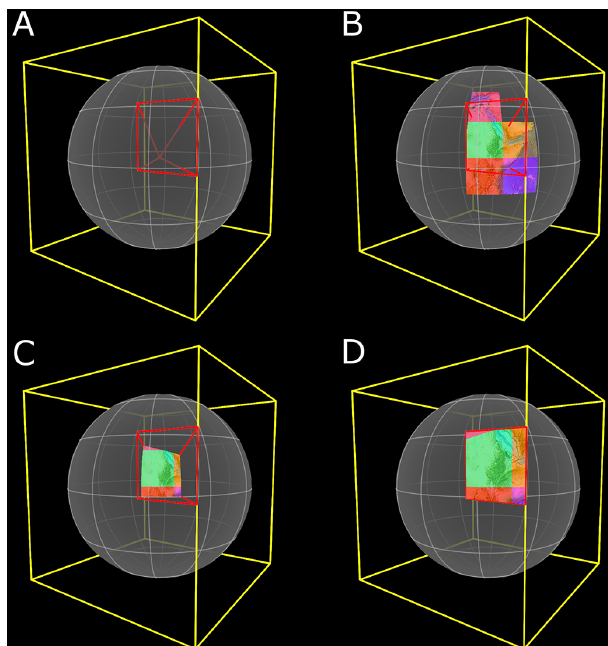
Figure 5. Rendering geo-referenced tiles into a single cube map tile of the ETOPO1 global raster (Amante and Eakins, 2009). The geo- referenced tiles are highlighted with different colours. The yellow wireframe represents the cube. (A) The red wireframe represents the perspective, off-axis pyramid frustum of the single cube tile. The pyramid apex is at the globe centre. (B) The subset of geo- referenced tiles that overlap the frustum of the single cube tile – note that tiles outside the frustum are culled. (C) The cube tile rendered on the sphere. This is the intersection of the geo-referenced tiles and the cube tile frustum. (D) The cube tile projected onto the cube face to show the actual cube tile texture (square 2-D image) and the contributions from the geo-referenced